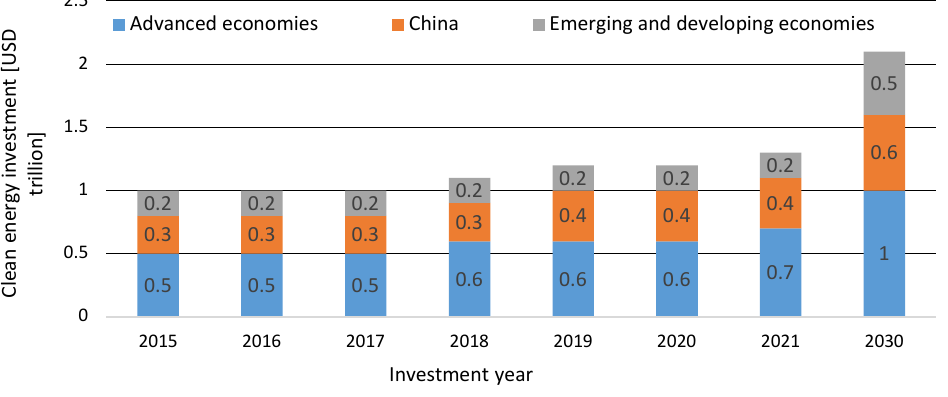
Figure 11. Global clean energy investment in the period 2015–2021 and forecasts for 2030 [37].